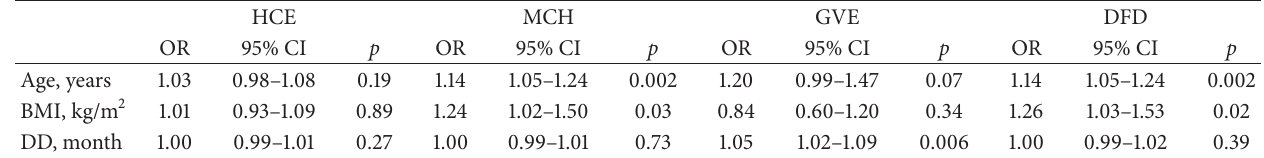
Table 4: Determinants of changes in the cardiovascular